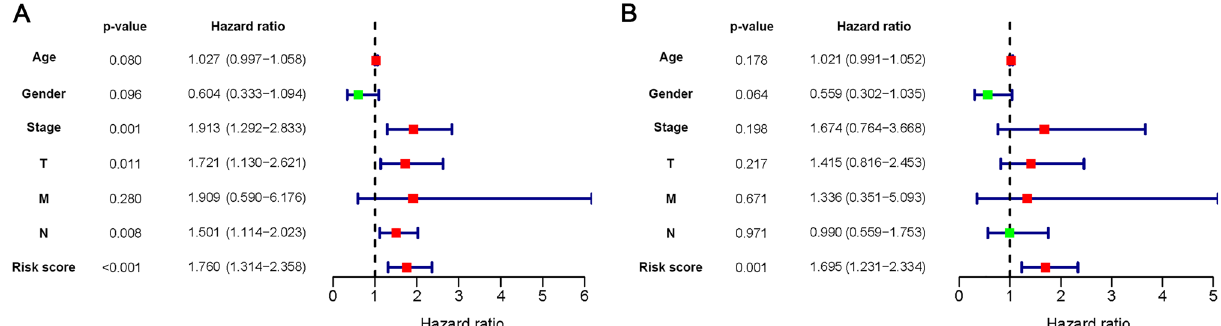
Figure 4. Univariate and multivariate Cox regression analysis. ( A ) Univariate Cox regression analysis to identify prognosis associated factors. ( B ) Multivariate Cox regression analysis to assess independent prognostic factors. The red and green dots represent variables with hazard ratio > 1 and ≤ 1,